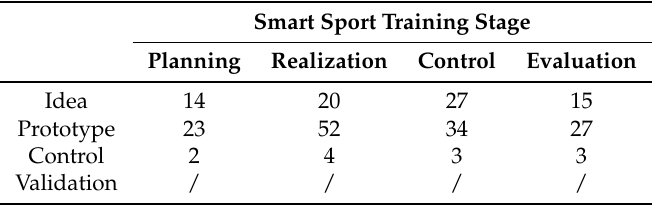
Table 21. Count of research by training stage and Technology Readiness Level (TRL) abstracted